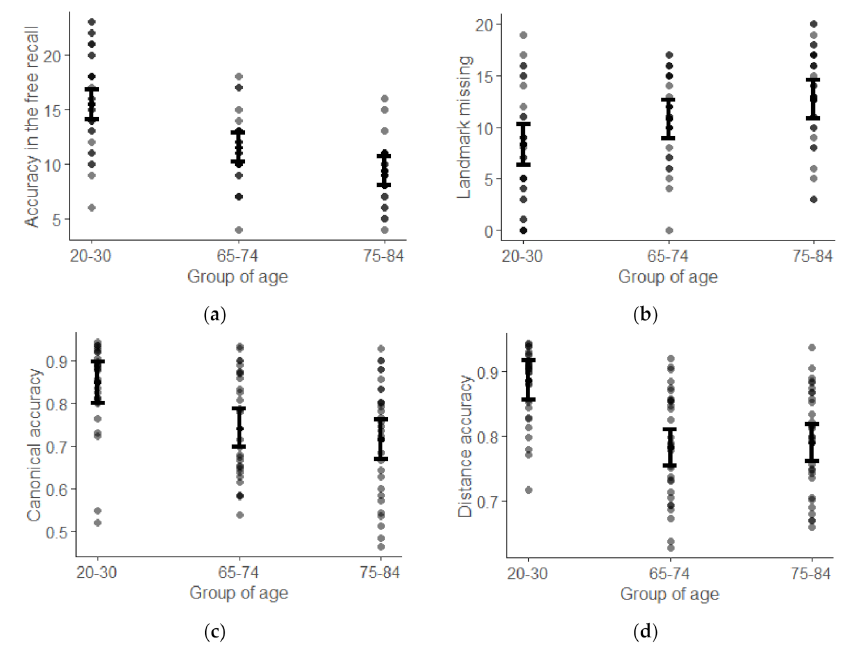
Figure 2. Age group effect in the regression models. ( a ) Groups of ages for free recall; ( b ) groups of ages for map drawing–missing landmark; ( c ) groups of ages for canonical accuracy; and ( d ) groups of ages for distance